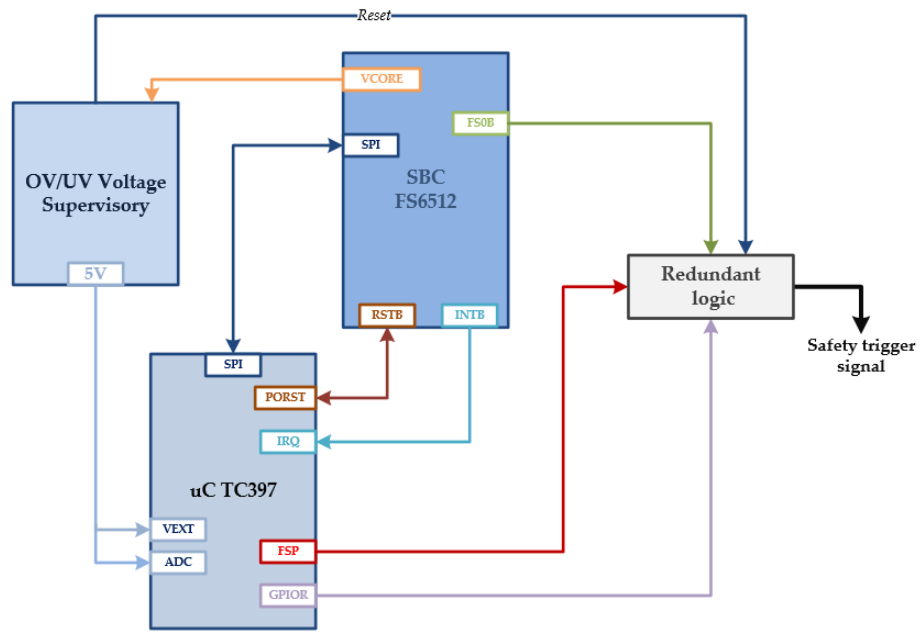
Figure 12. Safety switch off path proposal for transmission control unit (TCU) safety activation.